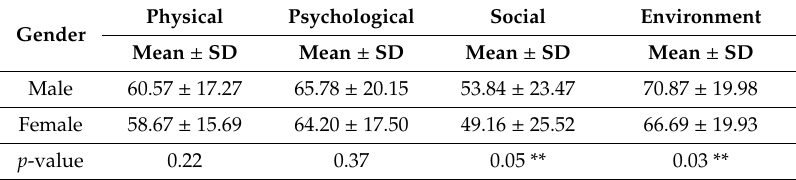
Table 2. Comparative analysis for the domains of the WHO quality of life (WHOQOL-BREF) among males and females.